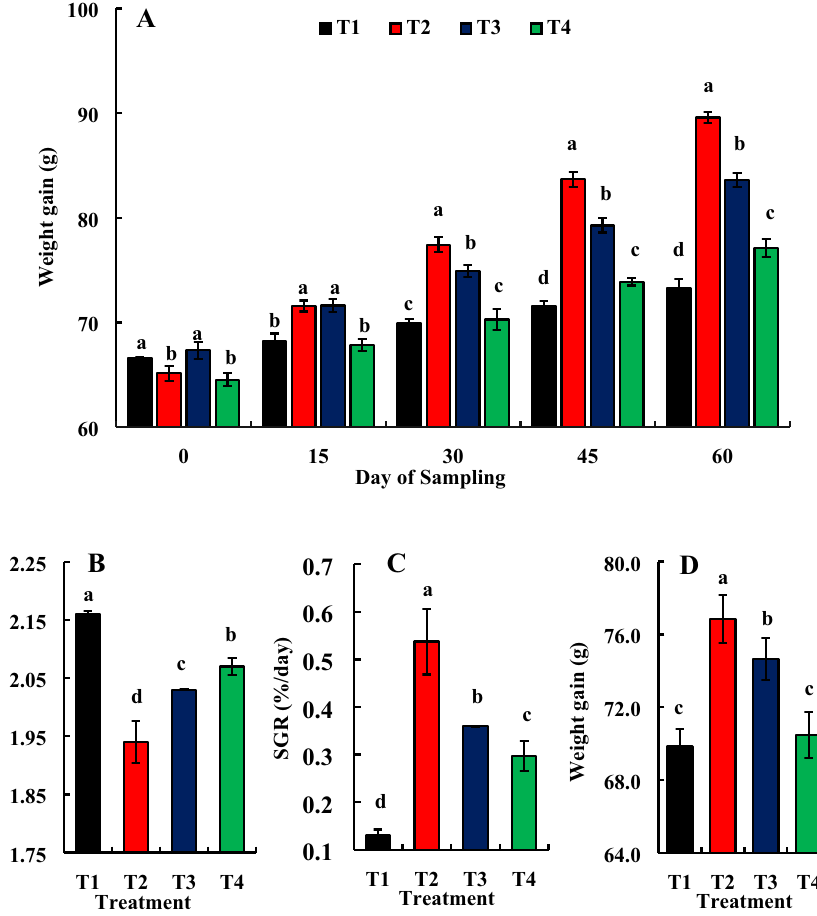
Figure 2. Assessment of consortium effects of five probiotic bacterial strains viz . GFB-1, GFB-2, GFB-3, GFB-4 and GFB-5 isolated from the gut of B. gonionotus on growth parameters (A, B, C and D) of the host fishes. Five probiotic bacterial strains were mixed with 1:1:1:1:1 ratio before adding in the formulated feed and fishes were reared for 60 days. Here, T1 = 0 CFU kg −1 feed (control); T2 = 1.35 × 10 9 CFU kg −1 feed; T3 = 2 × 1.35 × 10 9 CFU kg −1 feed and T4 = 3 × 1.35 × 10 9 CFU kg −1 feed. One way ANOVA was performed for analyzing the data of three replicated experiment and data in column varies significantly in LSD at P < 0.05 (Statistix 10). Different letter bars indicate significant variations in (A) weight gain, (B) food conversion ratio (FCR) and (C) specific growth rate (SGR) of the host fishes in different groups by the isolates at P < 0.05 (Statistix 10). Error bar = ± SD; n = 48. ( D ) Weight gain data collected were repeated statistically analysed using ANOVA to test significance results ( P < 0.05) between means. Standard error (± SE) was calculate to identify the range of means. These statistical analyses were performed with the aid of the computer software SPSS 26.0 version. R 2 values are as follows: T1 (Control) (0.801); T2 (0.834); T3 (0.807); T4